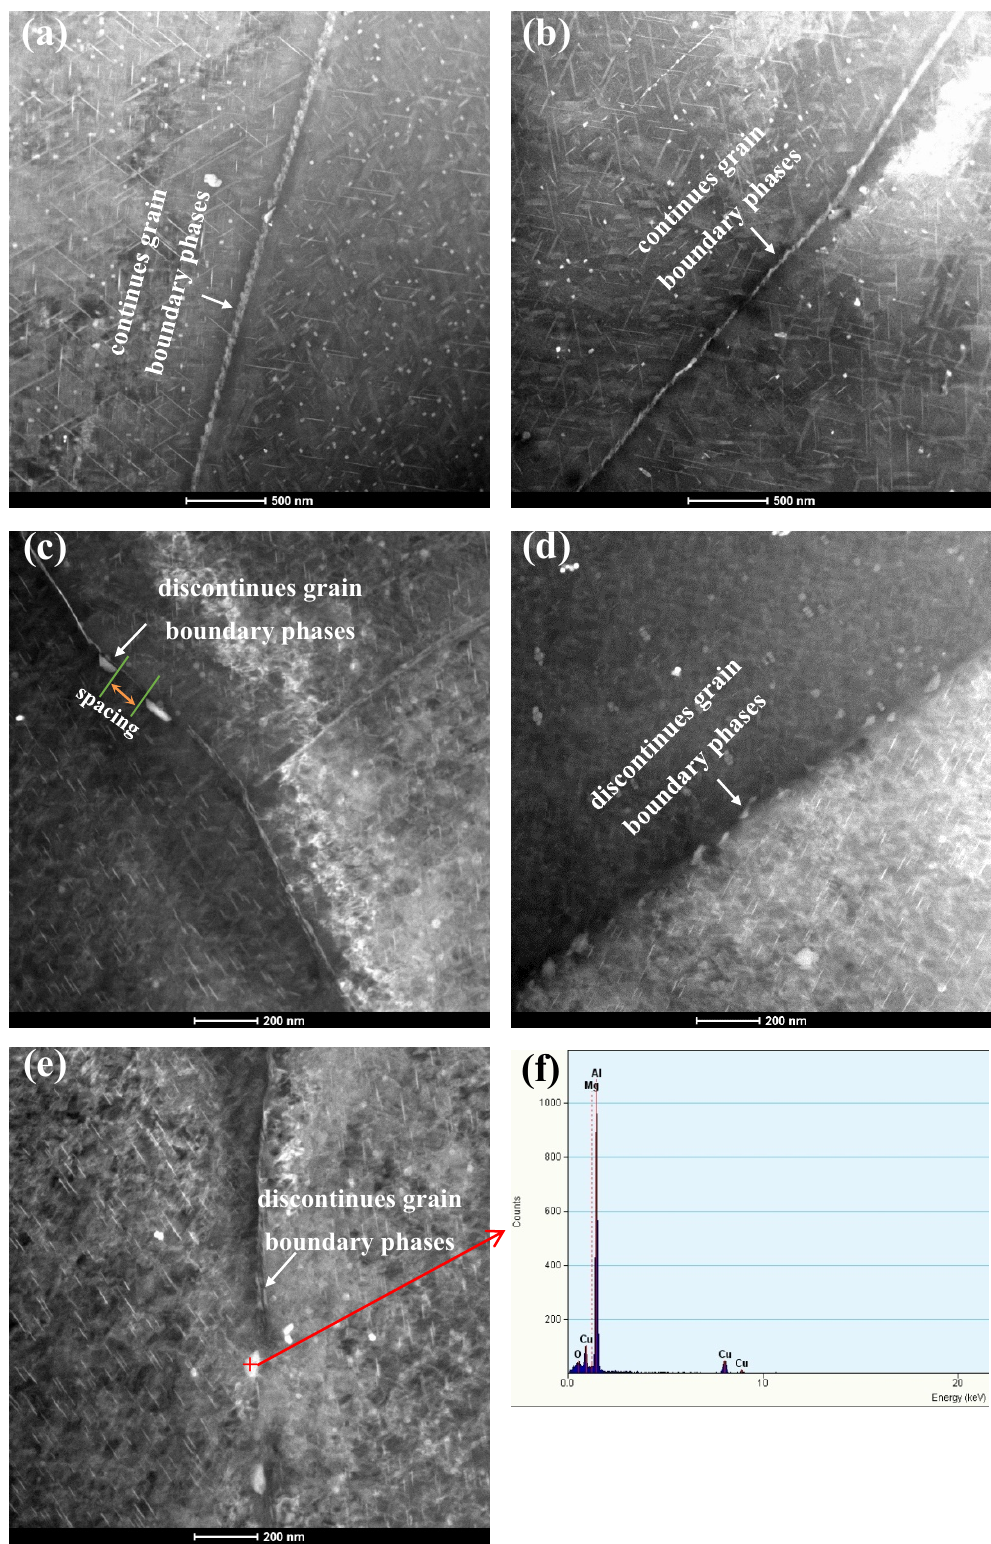
Figure 7. TEM micrographs of the five aged samples: ( a ) A1, ( b ) A2, ( c ) PA, ( d ) PCA, ( e ) PDA; ( f ) Energy dispersive X-ray (EDX) elemental maps of the framed area in ( e ).